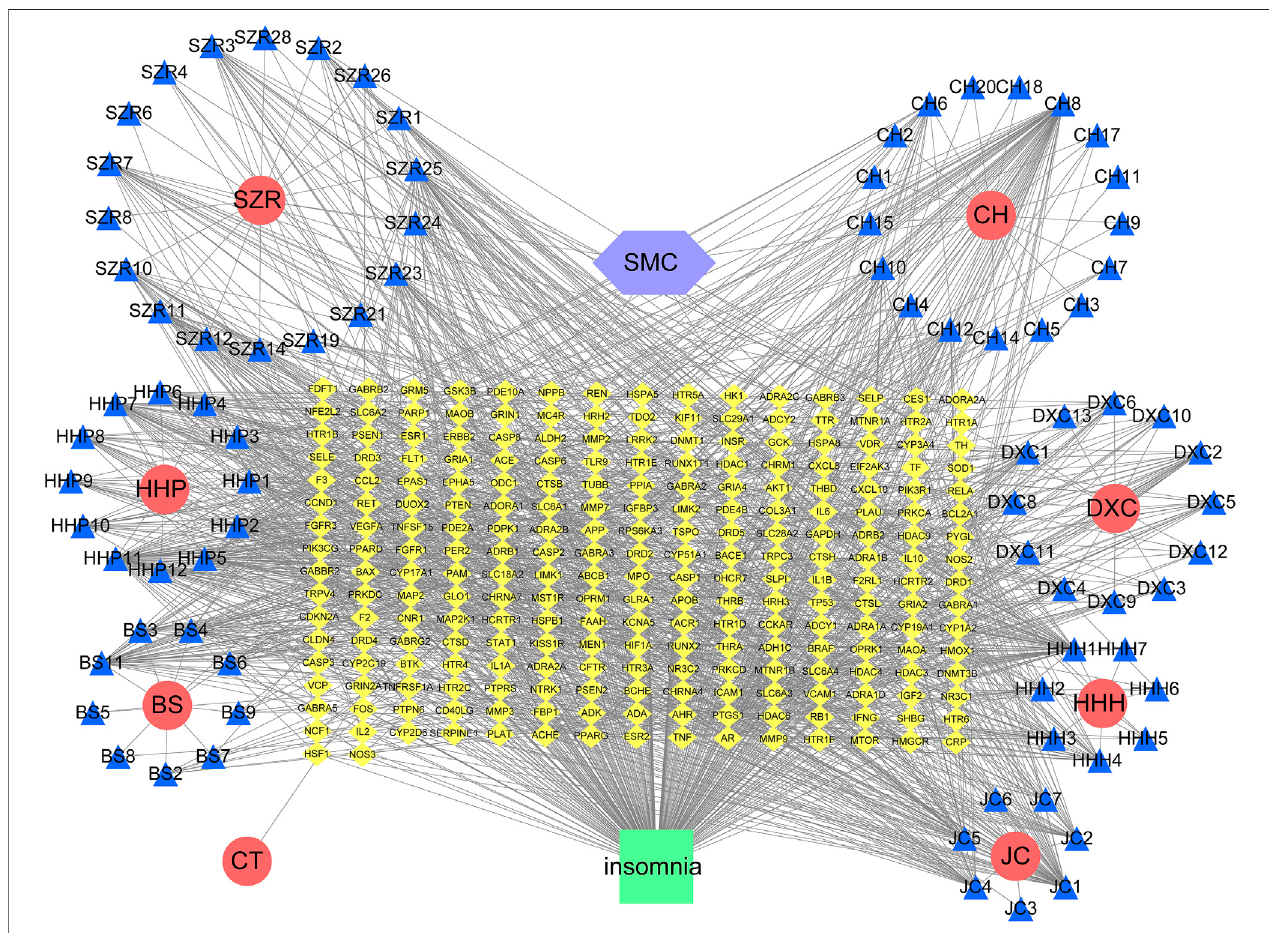
FIGURE 2 | Network diagram of active ingredients of SMC and insomnia intersection targets. In the network, SZR represents Ziziphi Spinosae Semen, CH represents Bupleuri Radix, HHP represents Albiziae Cortex, DXC represents Junci Medulla, BS represents Paeoniae Radix Alba, HHH represents Albiziae Flos, JC represents Bombyx batryticatus , and CT represents Cicadae